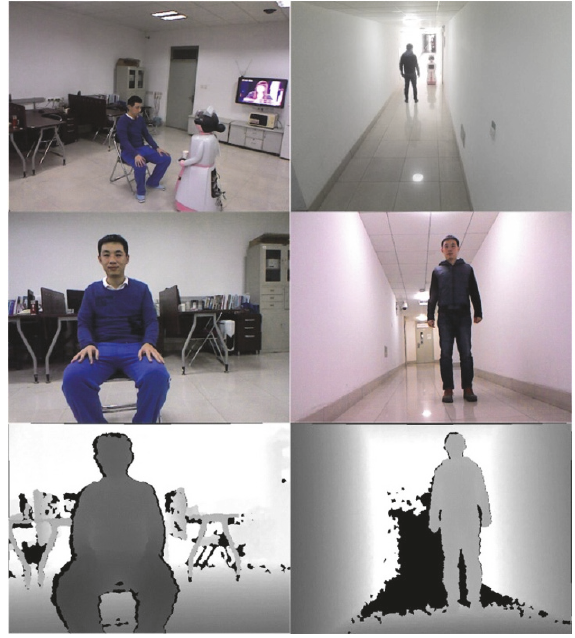
Figure 6: Original colour image and depth image in a corridor.